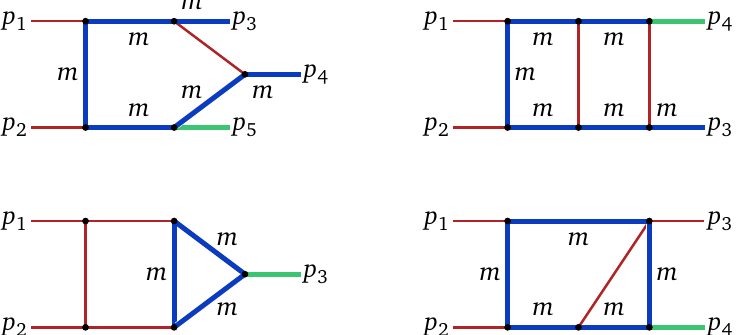
Figure 1: Feynman diagrams for our four example integrals, which we call pen- tagon1L, ladder2L (first line) and triangle2L, elliptic2L (second line). The blue lines denote massive lines, green lines denote massive or off-shell external legs (with a mass different from m